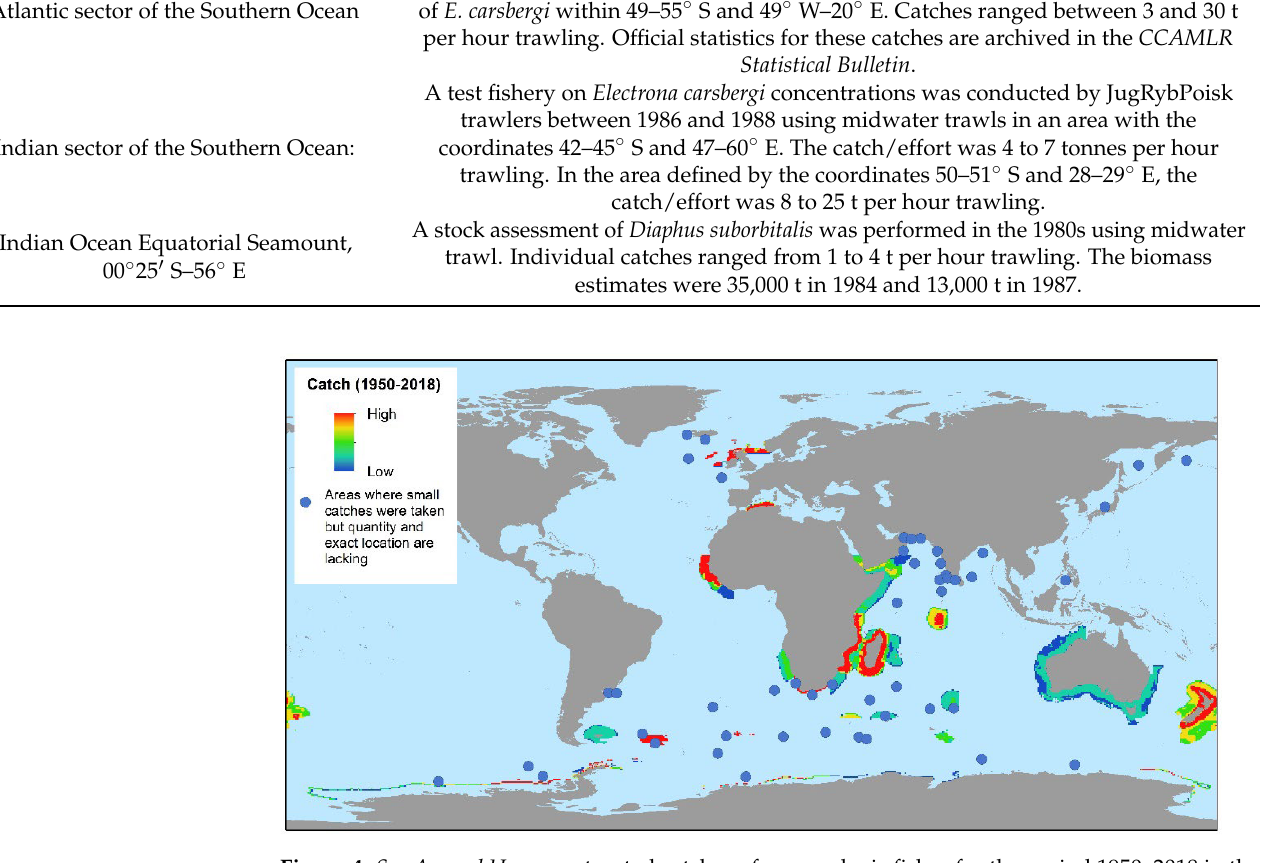
Figure 4. Sea Around Us reconstructed catches of mesopelagic fishes for the period 1950–2018 in the global oceans. Areas where small catches are taken (blue dots) but where quantity and exact location are unknown are listed in the Supplementary Materials and/or mentioned in the text. Table 4. Catch information for 20 mesopelagic fishes depicted in Figure 3 by country/region and year.